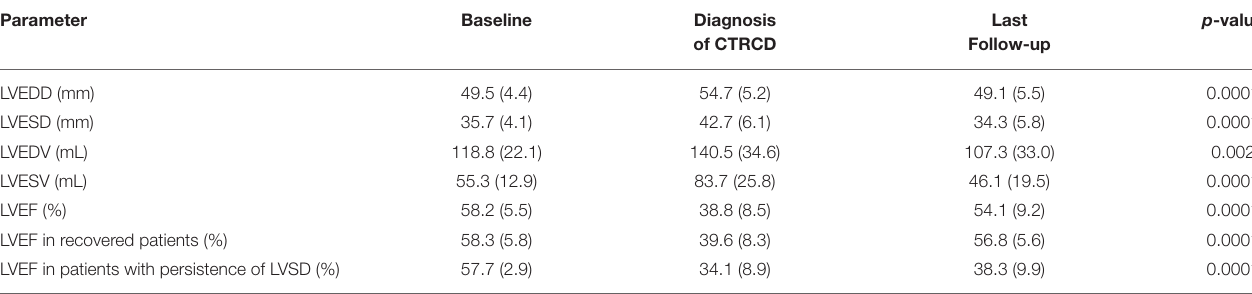
p -value Last of CTRCD Follow-up